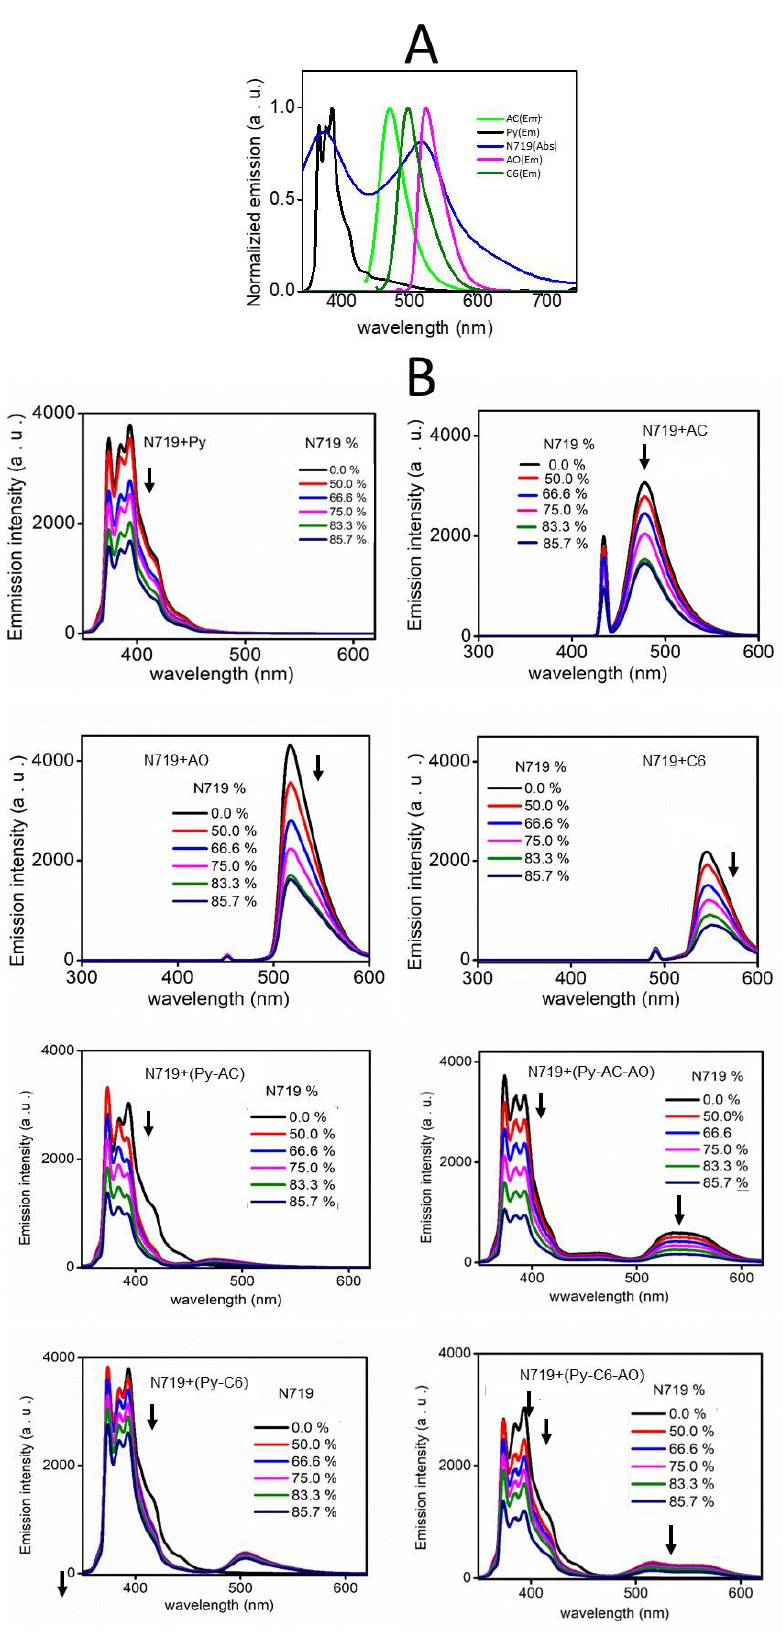
Figure 5. ( A ) Normalized emission spectra of FRET fluorescent dyes and an absorption spectrum of N719 (0.1 mM in ethanol). ( B ) Fluorescence emission spectra of ethanol solutions of Py(3 mM), AC(3 mM), AO(3 mM), C6(3 mM), Py(3 mM)-AC(3 mM), Py(3 mM)-AC(3 mM)-AO(3 mM), Py(3 mM)- C6(3 mM), and Py(3 mM)-C6(3 mM)-AO(3 mM) mixed with N719 at various